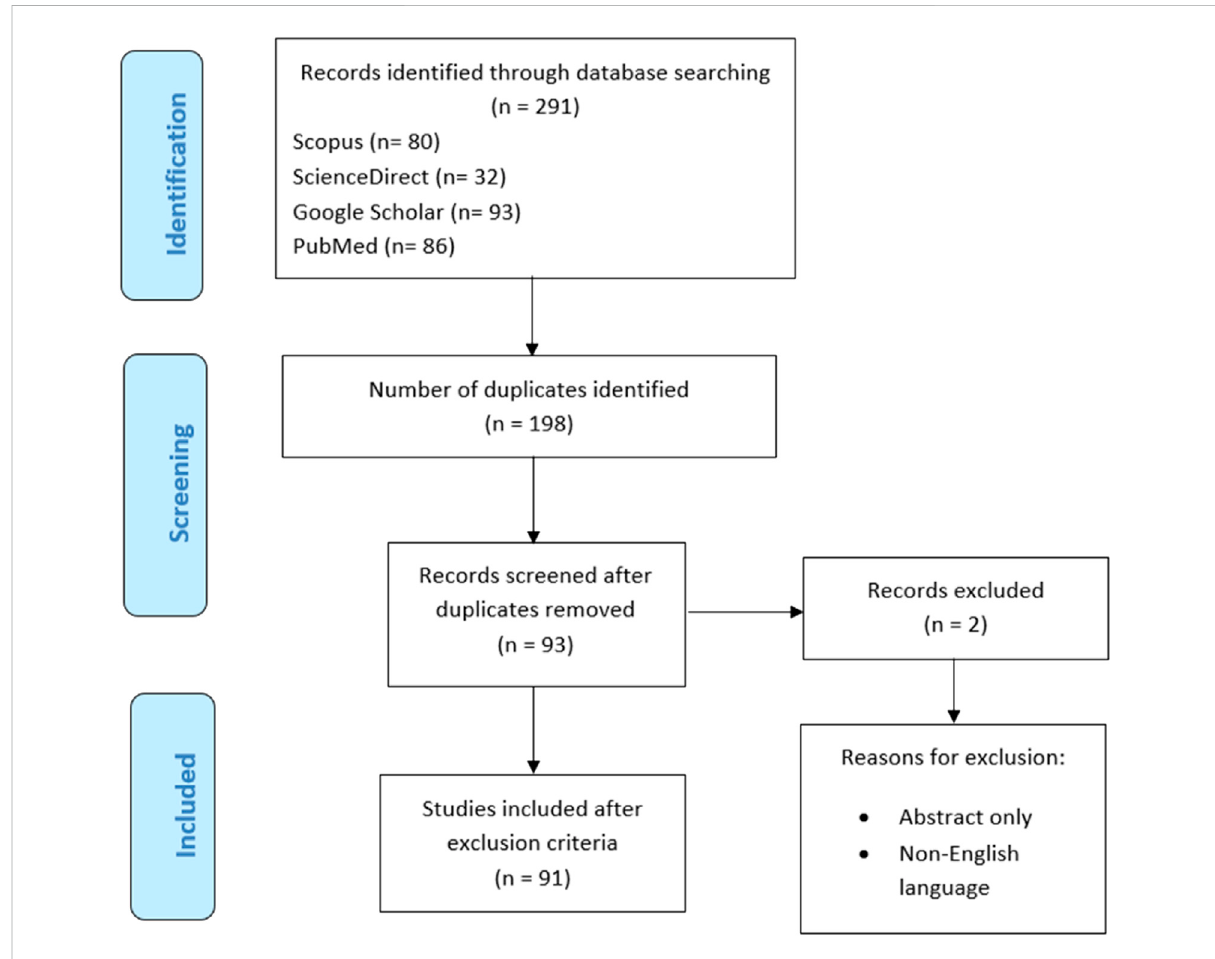
Flow chart used for systematic